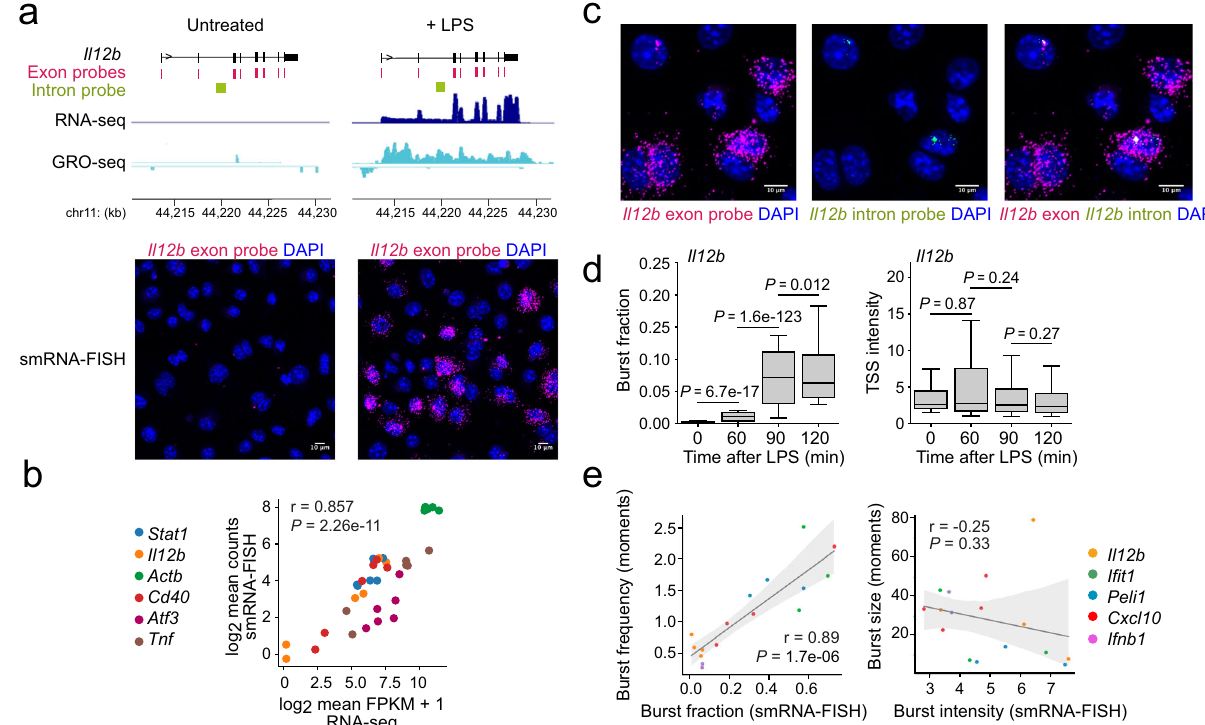
Fig. 1 Inducible gene transcription is regulated primarily by the fraction of actively transcribing alleles. a Induction of Il12b transcripts by macrophage activation as assessed by RNA-seq (top), GRO-seq (middle) and smRNA-FISH (bottom). LPS treatment times: 1 h for GRO-seq and 2 h for RNA-seq and smRNA-FISH. Representative of three independent biological replicates for RNA-seq, two independent biological replicates for GRO-seq and >3 independent biological replicates for smRNA-FISH. b Correlation between transcript abundance by RNA-seq (log 2 FPKM) and log 2 mean absolute transcript copy numbers by smRNA-FISH. r: Pearson correlation; P: p value in this and all subsequent fi gures. Statistical test: two-sided Pearson's product- moment correlation (Null hypothesis: correlation = 0). Il12b , Stat1 and Actb : three independent biological replicates, n = 8899 cells. Cd40, Atf3 and Tnf : 3 independent biological replicates, n = 12,372 cells. c Representative images illustrating the use of intron probes to localise transcriptional bursts. Greater than three independent biological replicates. d Burst fraction and burst intensity in resting and activated wild-type macrophages. In this and all subsequent box plot fi gures, boxes show the median and the upper and lower quartiles, whiskers show 1.5 of the interquartile range. P: p value. In this and